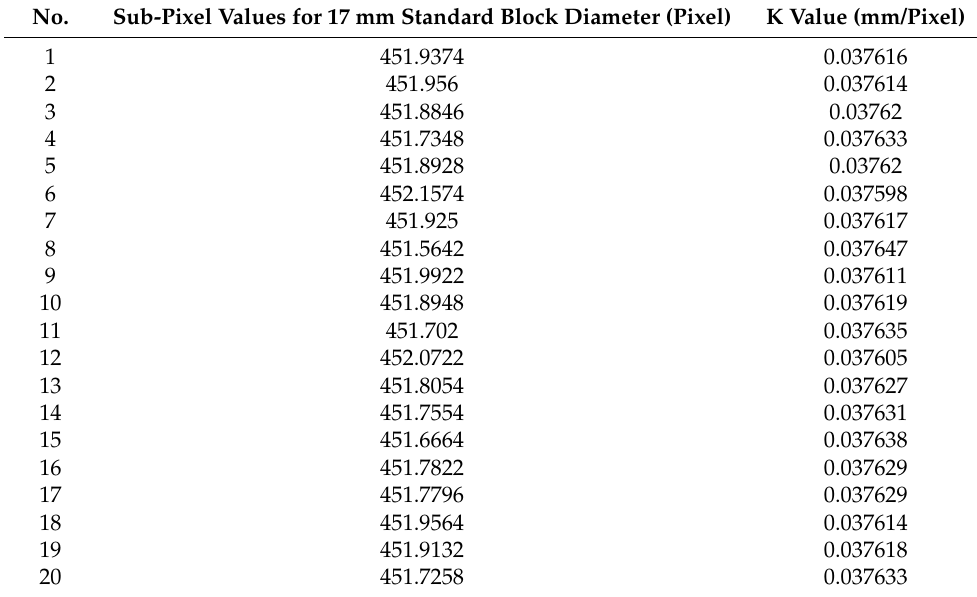
Table 1. Table of sub-pixel values and corresponding K values for the 17-mm standard block. No. Sub-Pixel Values for 17 mm Standard Block Diameter